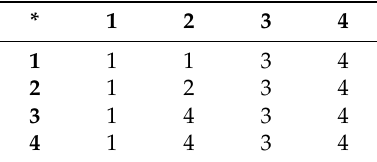
Table 2. Non-commutative NETG.